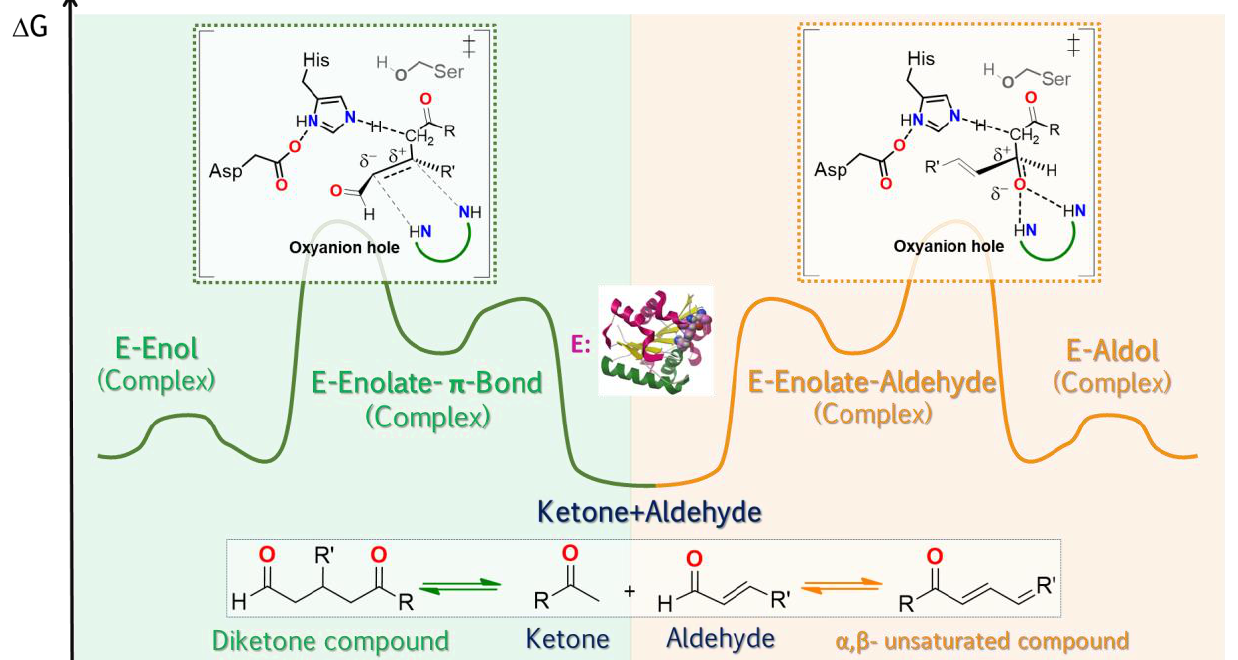
Figure 7. Schematic reaction coordinate vs. potential energy diagram for lipases. Representing an example of a catalytic promiscuity: the two-half panel, showing that the lipase can act in both directions, and product promiscuity: the enzyme as aldolase when faced with a substrate with two or more reaction possibilities, it is showed in each transition state (‡); as is the represented case of an unsaturated α , β aldehyde, the addition of ketone (in the form of enol) can occur in the β -position carbon or carbonyl carbon. One of the two products will be favored depending on which product favors the more stable conformation of the enzyme [135].